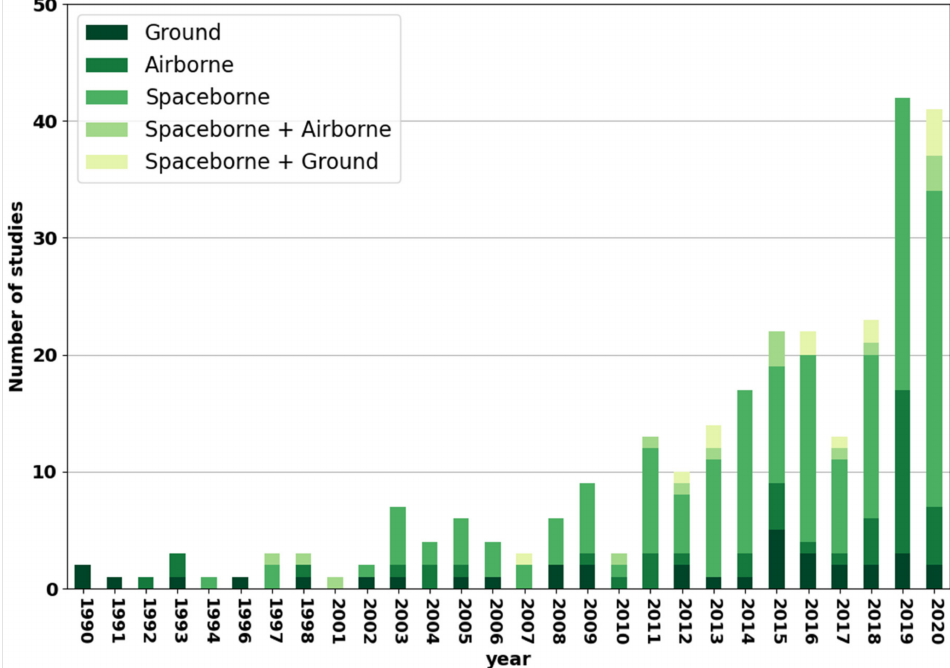
Figure 8. The variability of platforms used in screened articles, based on publication year.